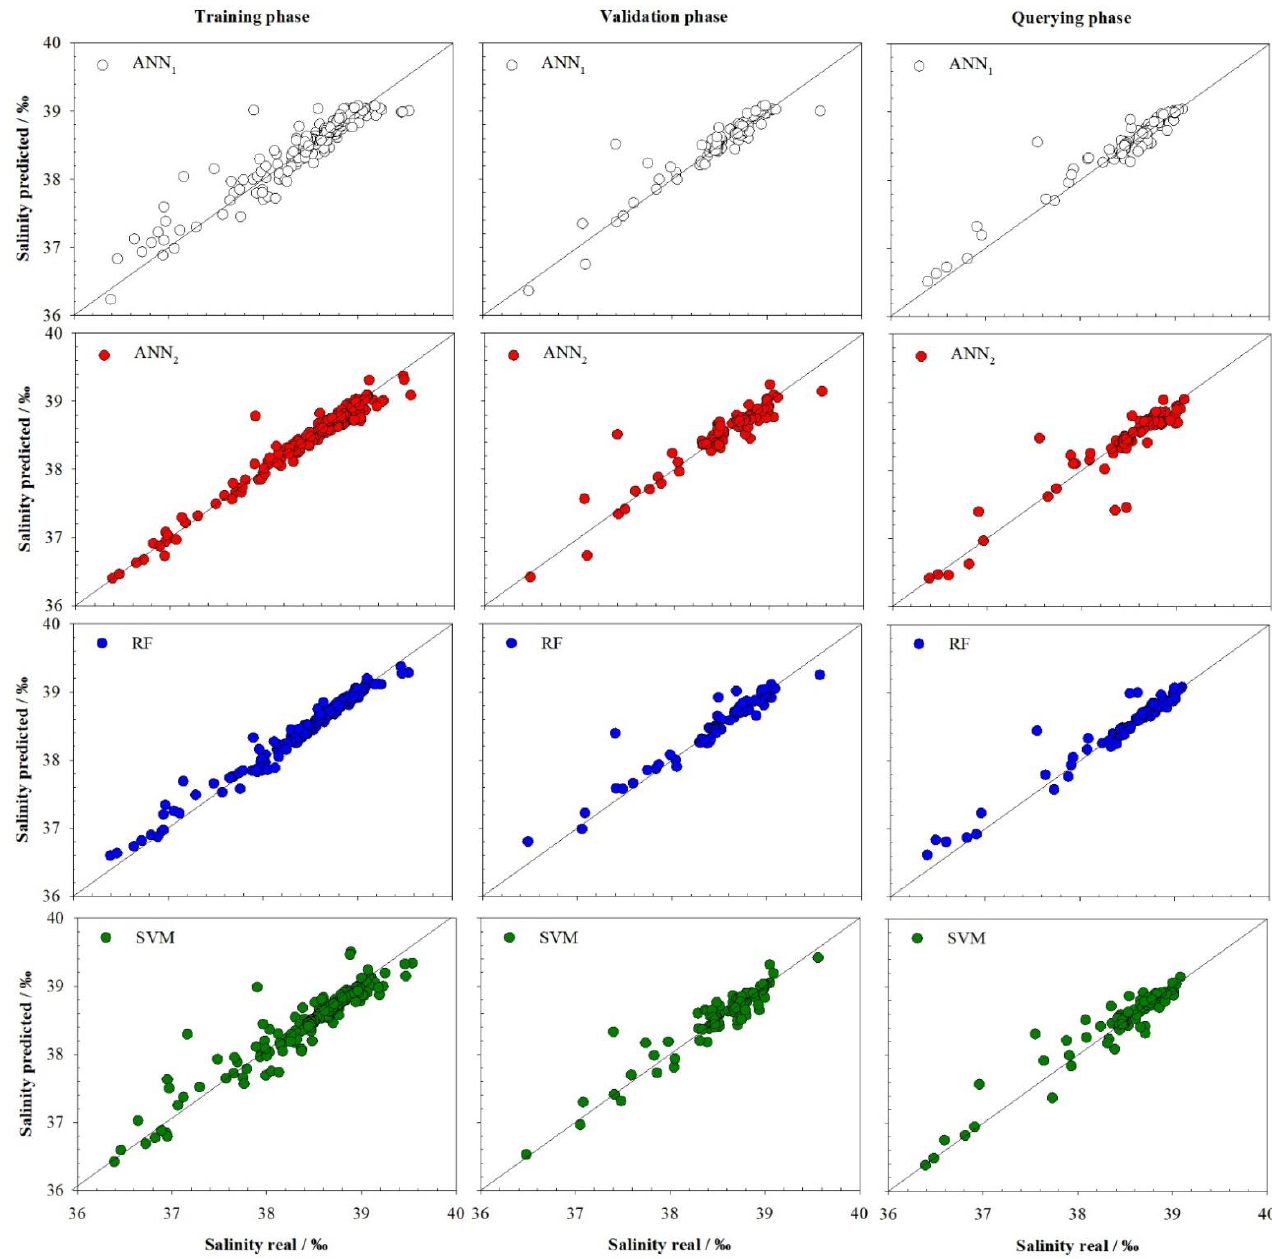
Figure 2. Real values vs. predicted values for salinity (‰) by artificial neural models ANN 1 and ANN 2 , random forest model (RF) and support vector machine model (SVM) developed. The black lines correspond to the line with slope one.